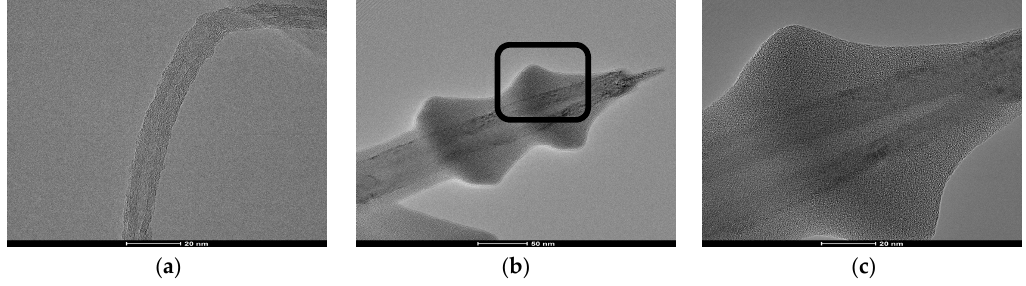
Figure 5. Surface of CNTs. ( a ) without nano-Ce(SO 4 ) 2 , ( b ) with nano-Ce(SO 4 ) 2 , ( c ) with nano-Ce(SO 4 ) 2.